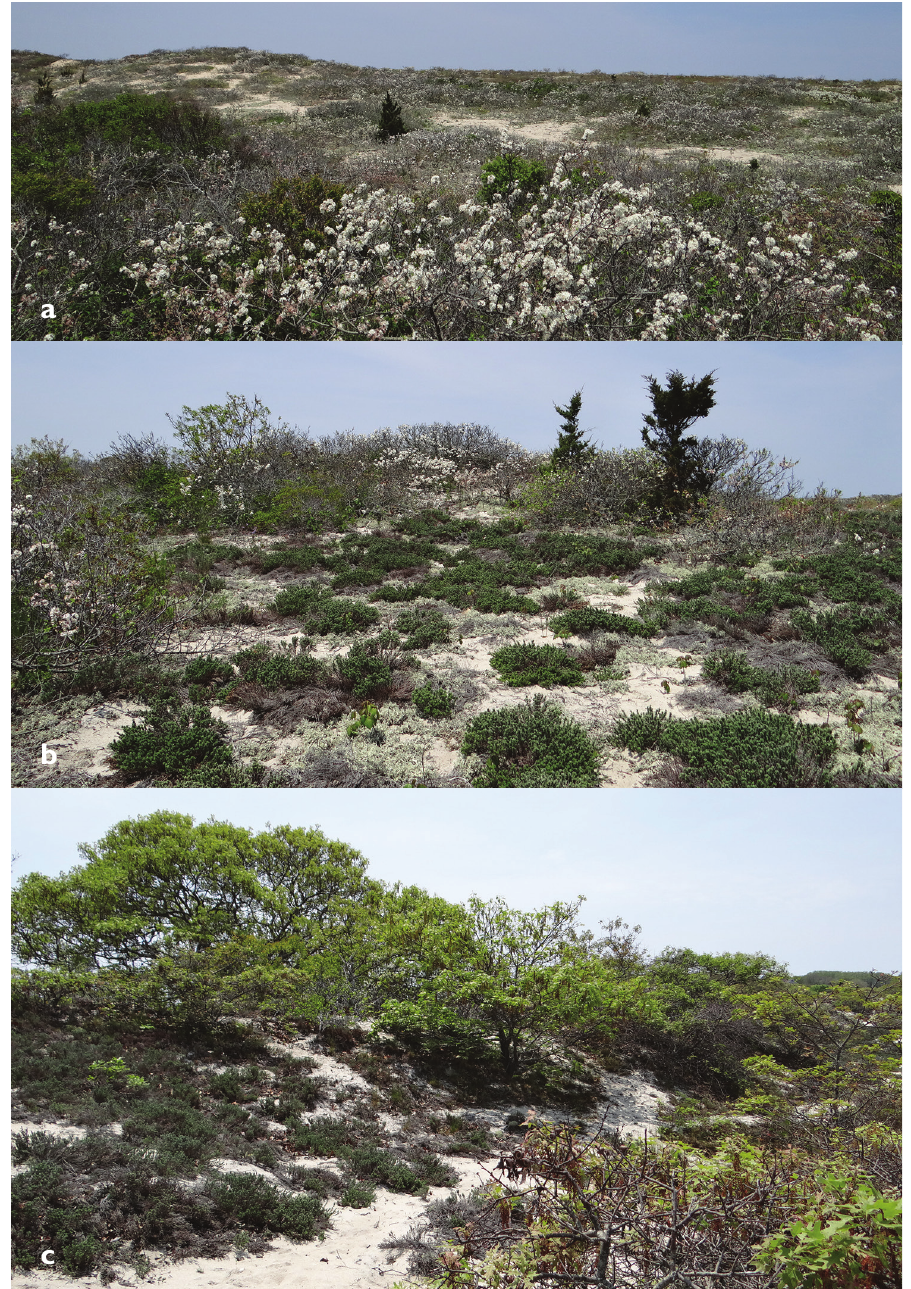
Figures 5. Examples of habitats represented at the Lobsterville Dunes. a Immediate backdune, domi- nated by beach plum, also in foreground b Floristic diversity on a secondary dune, the vegetation including beach heather ( Hudsonia tomentosa ) and heavy lichenization c A section of dune supporting a mixture of salt- and wind-dwarfed oak, including scrub oak ( Quercus ilicifolia ) in the